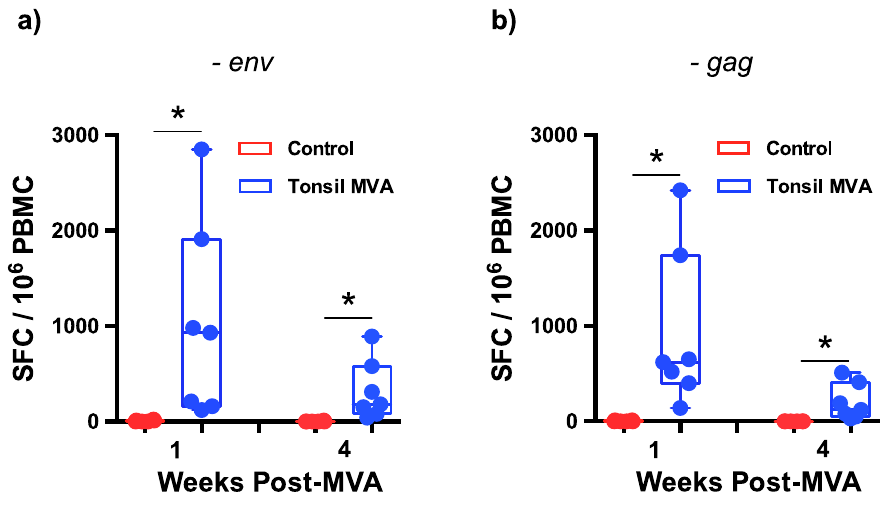
Fig.6|TonsilvaccinationinducedhighlevelsofTcellELISPOTresponsesprior to challenge. SIVmac239 ( a ) env (week 1 control vs week 1 post-MVA P =0.0006; week4controlvsweek4post-MVA P =0.0006)and( b )gag(week1controlvsweek 1 post-MVA P =0.0006; week 4 control vs week 4 post-MVA P =0.0006) speci fi c T cell responses in PBMC by ELISPOT assay at 1 and 4 weeks after tonsil vaccination